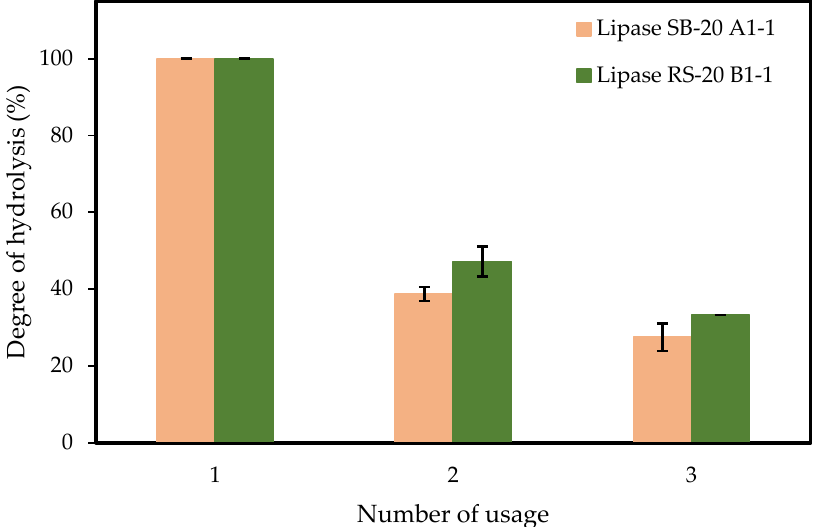
Figure 10. Comparison of reusability in terms of hydrolysis degree for immobilized lipase on sugarcane bagasse (SB ‐ 20 A1 ‐ 1) and rice straw (RS ‐ 20 B1 ‐ 1).